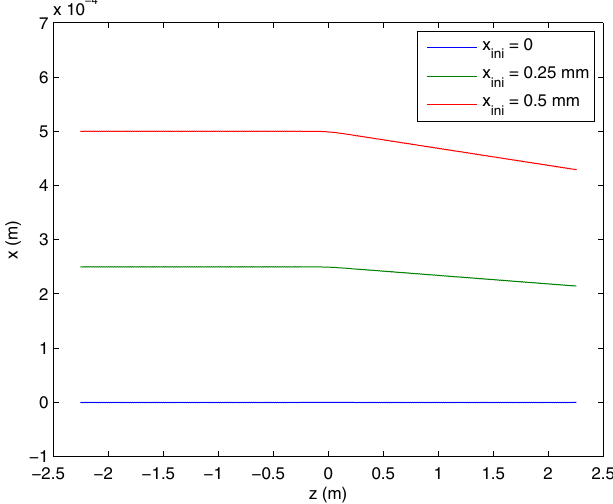
FIG. 13. Trajectories inside a segmented undulator with a quadrupole focusing. The undulator has two segments each ¼ 100 periods. The separation between the two is with N u 0.486 m. A single horizontally focusing quadrupole of length 0.3 m is located at the center with 3 : 5 T = m